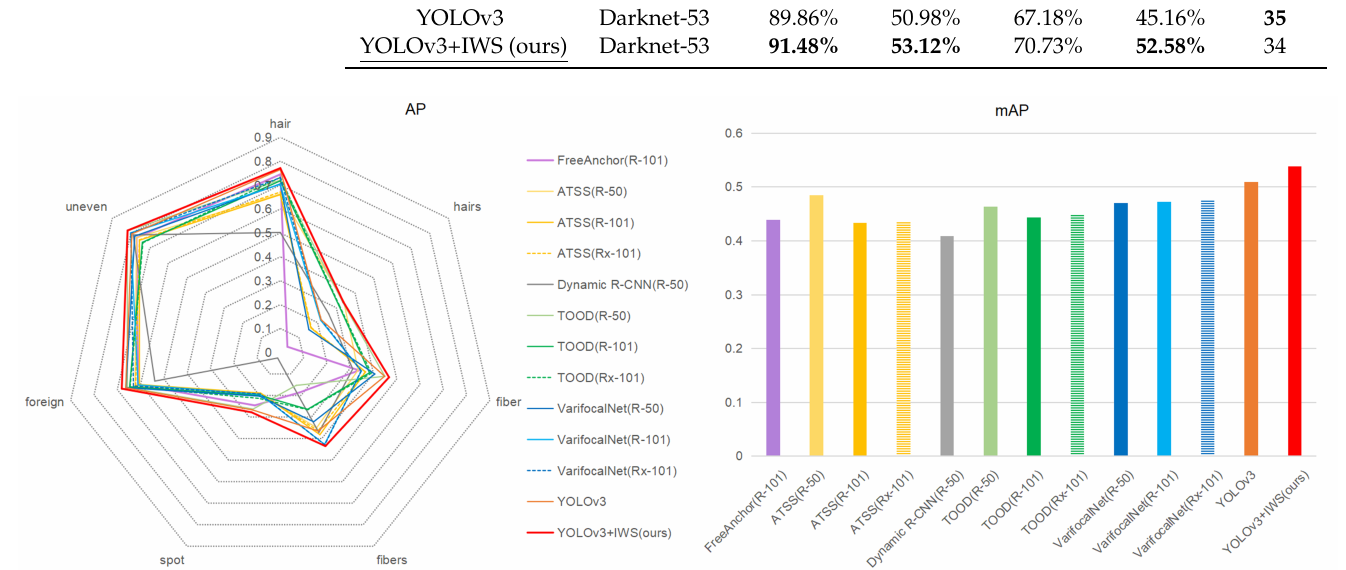
Figure 10. Comparison of AP values for each class of models with mAP exceeding 40% (R-50: Resnet-50, R-101: Resnet-101, Rx-101: